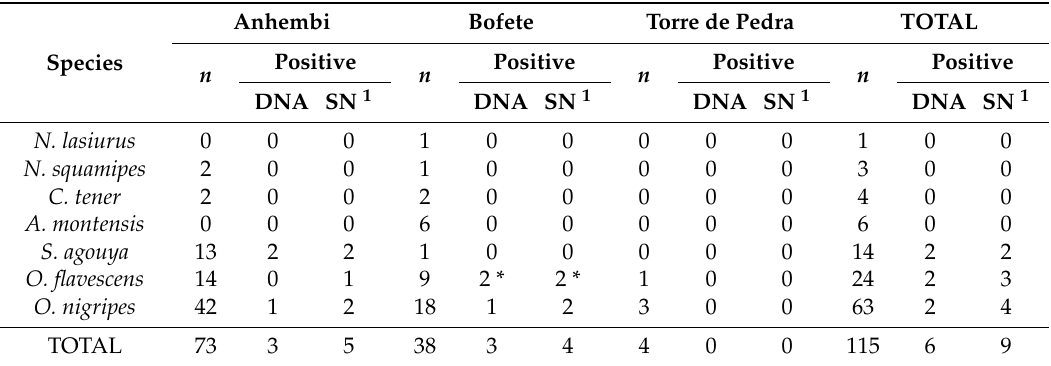
Table 3. Correlation between detection of VACV DNA in fecal samples and previous seropositivity (SN) in the same sampled wild rodents [14].